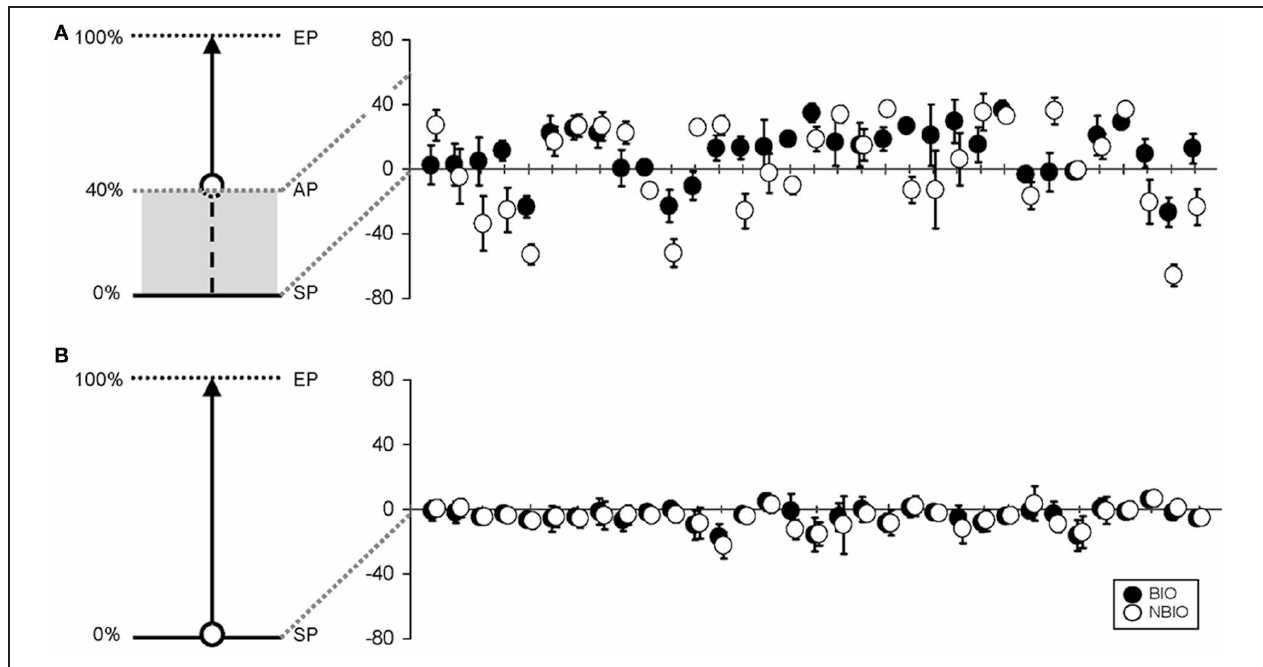
standard deviation). (B) On the left, a schematic representation of the experimental set in Experiment 2: the stimulus trajectory was completely visible. On the right, mean vertical error for the 33 participants [black dots for the Biological (BIO) condition, white dots for the Non-Biological (NBIO) condition] for estimated SP (error bars for